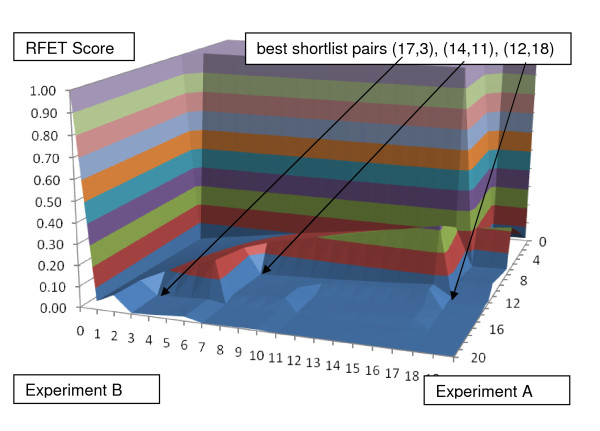
BLANKET applied to a second set illustrative lists of n = 500 descriptors. Descriptors in Experiment A are ranked in canonical order 1, 2, ..., 500. To the same ranking, weighted noise is added to arrive at an Experiment B ranking of 7, 26, 17, 32, 21, 34, 12, 46, 49, 14, 57, 54, 67, 19, 61, 28, 1, 15, 82,... BLANKET finds no shortlists of length at most 10 that meet the criteria for significance (p-value ≤ .05, corresponding to RFET < .00105). However, BLANKET finds three shortlist pairs as shown of length < 20 that do meet the same (RFET < .00800). Thus BLANKET, not knowing the effects of noise, would recommend to the researcher these descriptors for further investigation. Note the characteristic sharp decline in RFET values near the chosen shortlists. This example is relevant to the case of one experiment performed with great accuracy and the other with substantial noise. Note that each selected shortlist pair (p, q) has unequal numbers of descriptors selected from both experiments (p ≠ q).